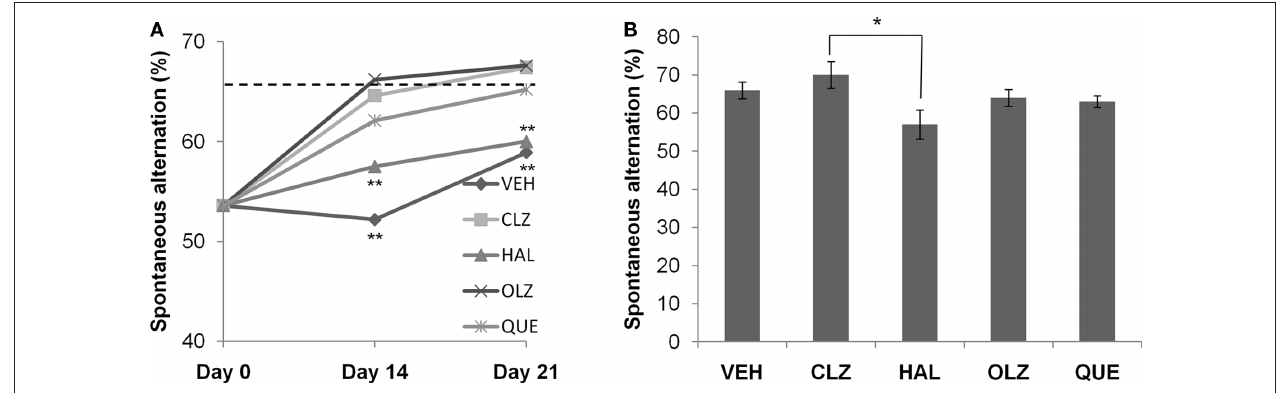
Figure 4 | Atypical antipsychotic drugs, but not haloperidol, promoted the recovery of spontaneous alternation after CPZ withdrawal. (A) The data from the recovery experiment, in which the dotted line indicates the value of the controls (CNT). (B) The data from mice exposed to antipsychotics, but not to CPZ. Data are mean ± SEM ( n = 6–12/group). ** p < 0.01, compared to CNT.